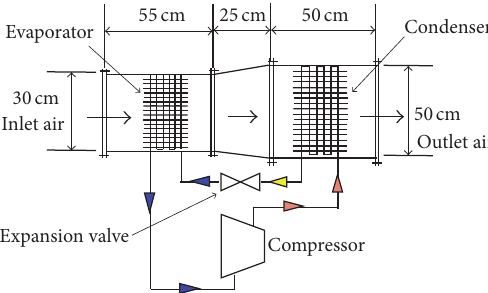
Figure 3: Dimensions of evaporator and condenser of heat pump.